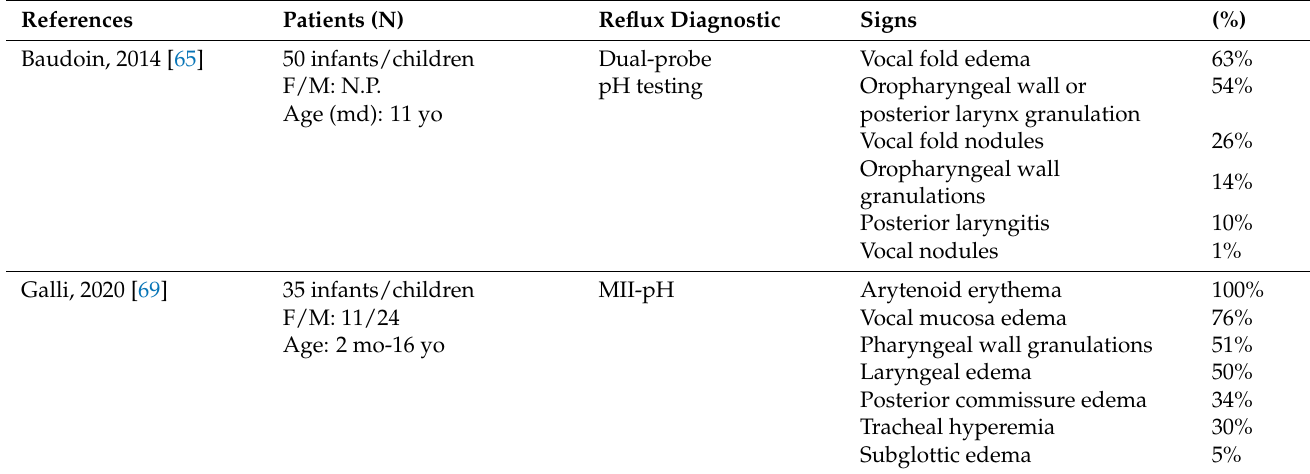
Table 3. Signs of Pediatric Laryngopharyngeal